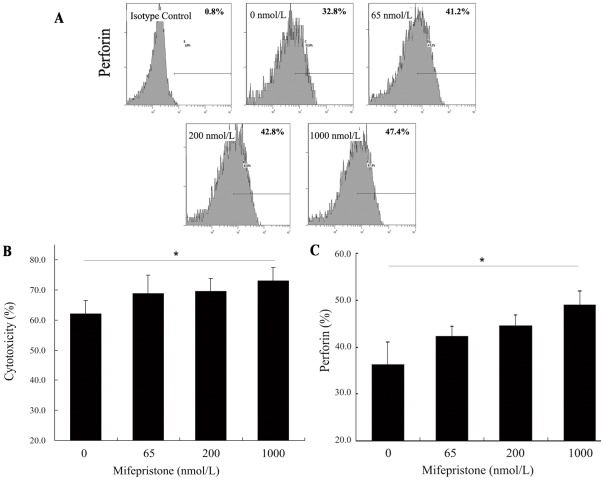
Analysis of uNK-cell cytotoxicity and perforin expression after treatment with different concentrations of mifepristone.The purified uNK cells were incubated with 0, 65, 200, and 1000 nmol/L mifepristone for 24 h. Then, they were subjected to analysis of uNK-cell cytotoxicity and perforin expression. A, a representative flow cytometry profiles of perforin expression was shown. Uterine NK-cell cytotoxicity (B) and perforin (C) expression after treatment with different concentrations of mifepristone were evaluated. Values are expressed as means ± SEM. The influence of mifepristone was evaluated by 4 independent experiments. P-values referred to One-way analysis of variance, n = 6, * P<0.05 vs. control group.